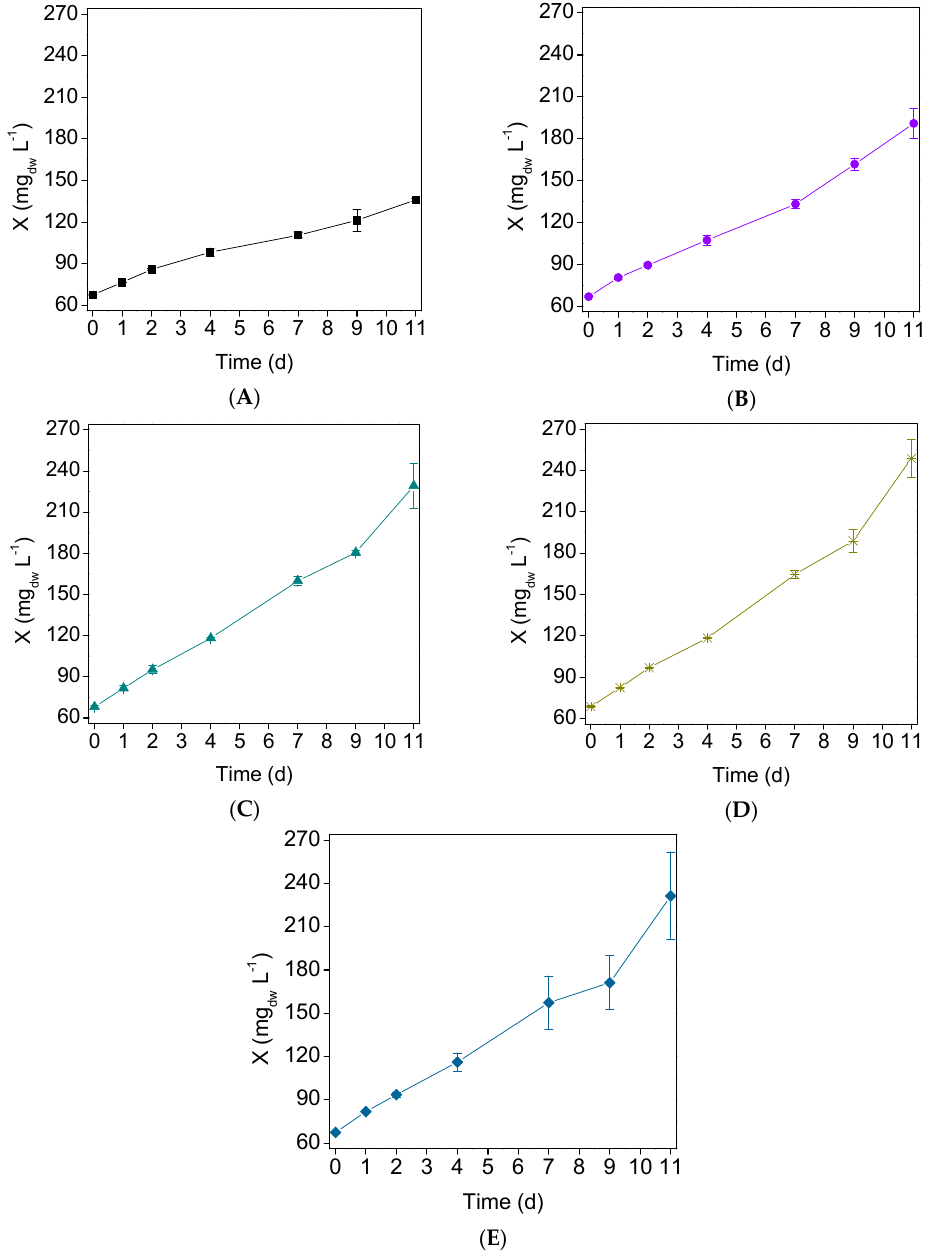
Figure 2. C. vulgaris cultures growth curves in raw and diluted secondary-treated paper industry effluent: ( A ) Assay 1 ; ( B ) Assay 2 ; ( C ) Assay 3 ; ( D ) Assay 4 ; and ( E ) Assay 5 . Error bars correspond to the standard deviation of the mean obtained from two independent experiments.